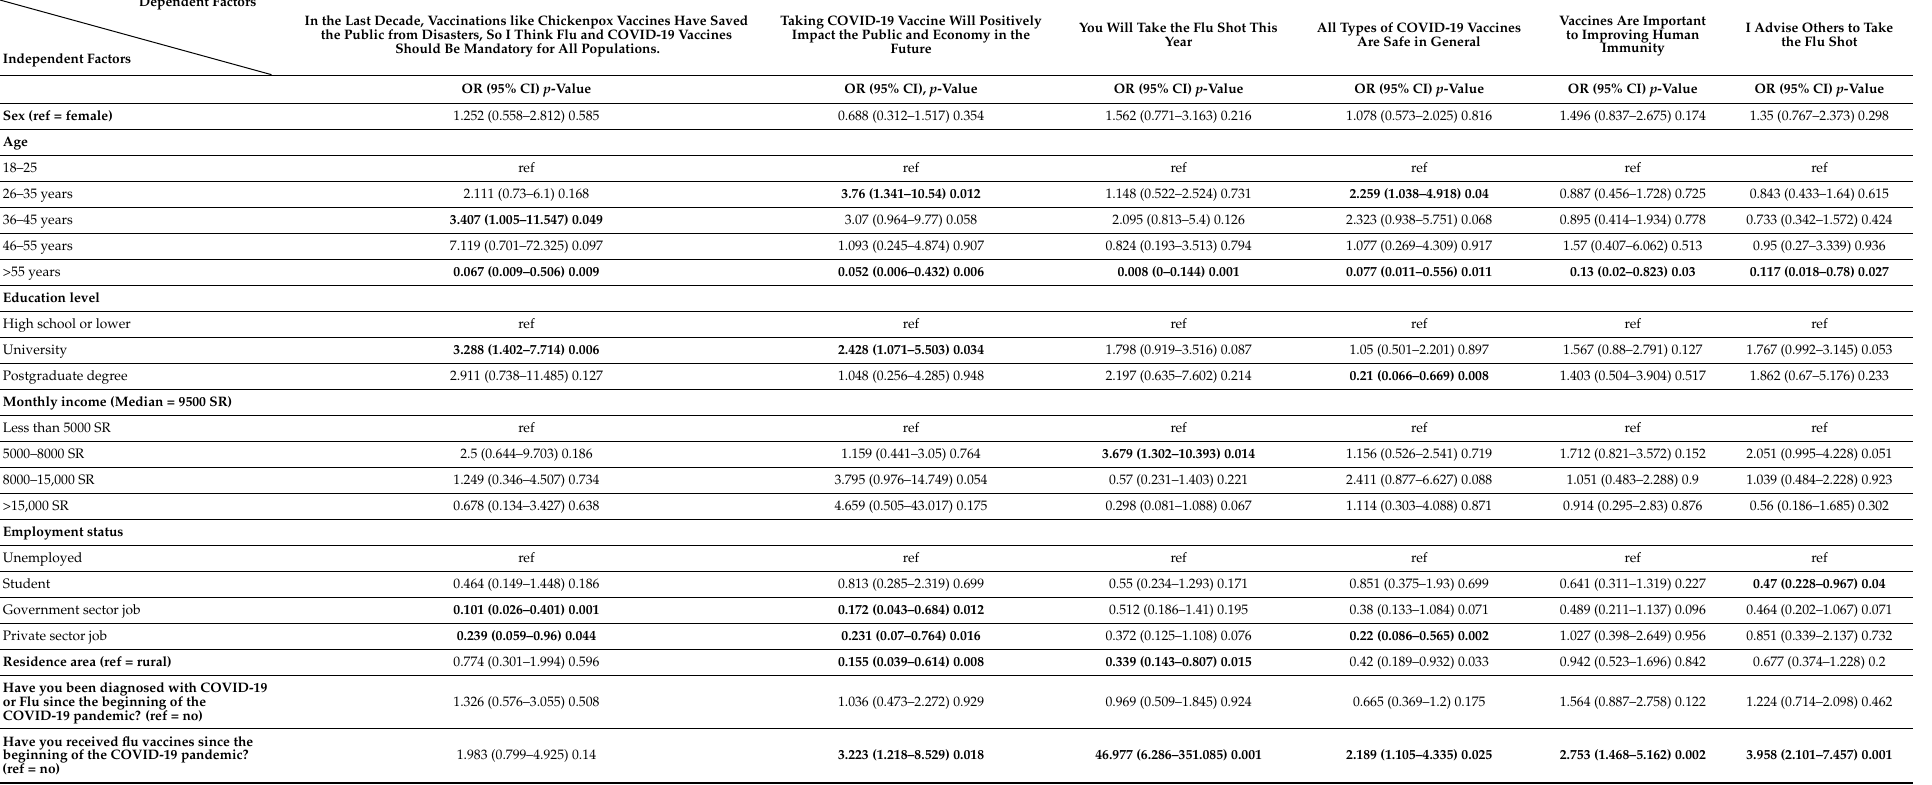
Table 3. Logistic regression model examining factors affecting the sufficient knowledge towards flu and COVID-19